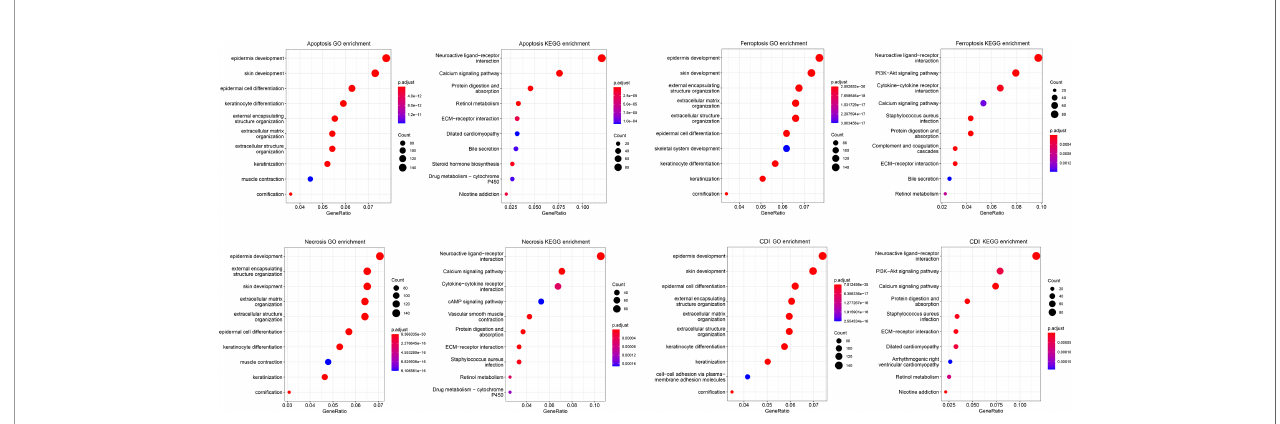
FIGURE 6 | Functional enrichment analysis of cell-death pathways. The bubble chart shows GO and KEGG functional enrichment analyses of cell-death-related genes for